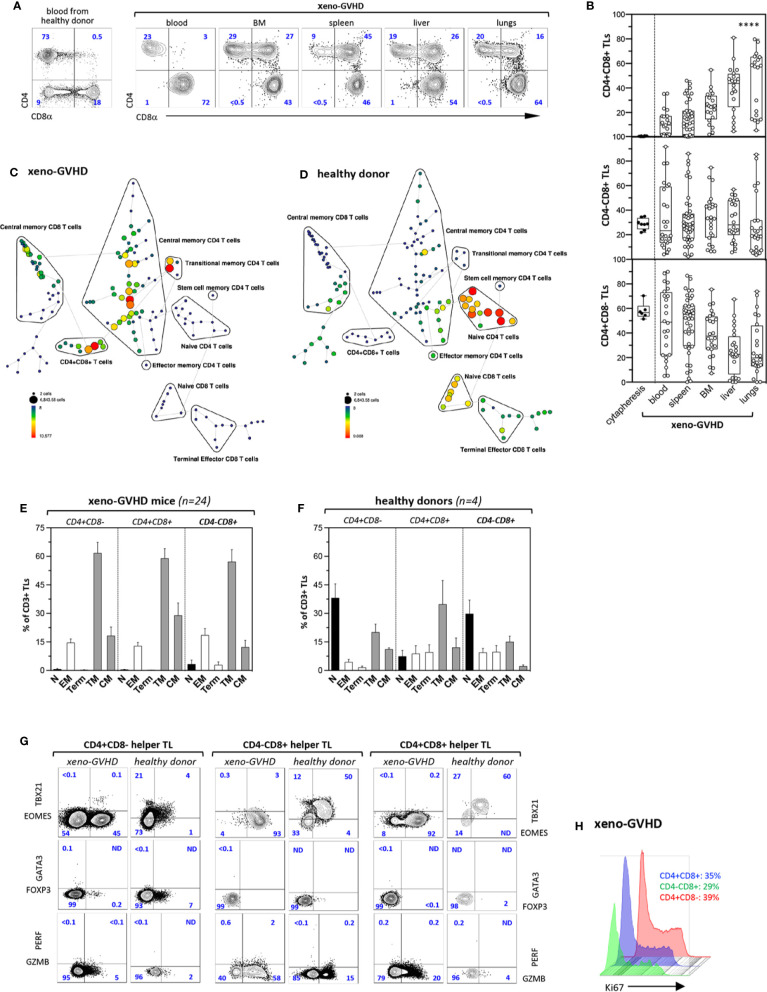
Xenogeneic GVHD induce tissue accumulation of CD4+CD8+ memory TL. (A) Phenotype of CD3+ TL isolated from the blood of a healthy donor (left panel) or from the blood and aGVHD target organs of a diseased mouse (right panels). Sub lethally irradiated mice injected with 3 × 106 PBMCs were sacrificed 4 to 6 weeks later (weight loss was >15%). Gates are set on human (hu) CD45+CD3+ TL; contour plots show percentages of the CD4+CD8−, CD4−CD8+, and CD4+CD8+ subsets. (B) Distribution of CD4+CD8−, CD4−CD8+, and CD4+CD8+ hu-TL in blood (n = 23), spleen (n = 36), BM (n = 25), liver (n = 27), and lungs (n = 23) of diseased mice. Diseased mice were sacrificed 4 to 6 weeks after transplantation. After staining for surface antigens cells were analyzed by flow cytometry. Box and whisker plots display the median, 25th, and 75th percentile of the distribution, and whiskers extend to the most extreme data points. Black and empty circles correspond respectively to individual donor apheresis or diseased mice. Data are compiled from four independent experiments. Data are compiled from 4 independent experiments. Asterisks indicate statistical significance based on the Kruskall-Wallis test (p < 0.0001****). (C, D) Tree plot representation showing immunophenotypic stratification of TL subsets isolated from the (C) the spleen of a representative aGVHD mouse injected with PBMC from (D) the blood of a healthy donor. Down sampling and clustering analysis based on expression of 16 cell-surface markers (CD4, -8a, -45RA, -25, -27, -28, -56, -62L, -69, -95, -103, -122, -127, -197, -199, -279) was performed using the Spanning-tree Progression Analysis of Density-normalized Events (SPADE) algorithm. The size and color of each circle indicate the frequency of cells. Populations of interest were annotated manually and represented as black lines encircling the corresponding set of nodes. (E, F) Immunophenotypic stratification of hu-TL subpopulations circulating in the blood of (E) aGVHD mice or (F) from the corresponding healthy donor. Gates were set as shown in panels A and C. Bars represent mean percentages ± standard deviation of the indicated populations. Results are from 4 healthy donor apheresis and 24 xeno-GVHD mice. (G) Expression of transcription factors EOMES, TBX21/TBET, GATA3 and FOXP3, as well as of cytolytic markers PERF and GZB by CD4+CD8−, CD4−CD8+, and CD4+CD8+ TL subsets from the spleen of a diseased mouse (left columns) transplanted with PBMC from the same healthy donor (right columns). Cells were fixed, permeabilized and labeled with an eight-color antibody panel. Bi-dimensional contour plots show expression of the indicated markers. Percentages of the corresponding populations are indicated. (H) Histograms show expression of proliferation marker Ki-67 by hu-TL from the spleen of a diseased mouse. Cells were processed as indicated above. Percentages of Ki-67–positive cells are indicated.